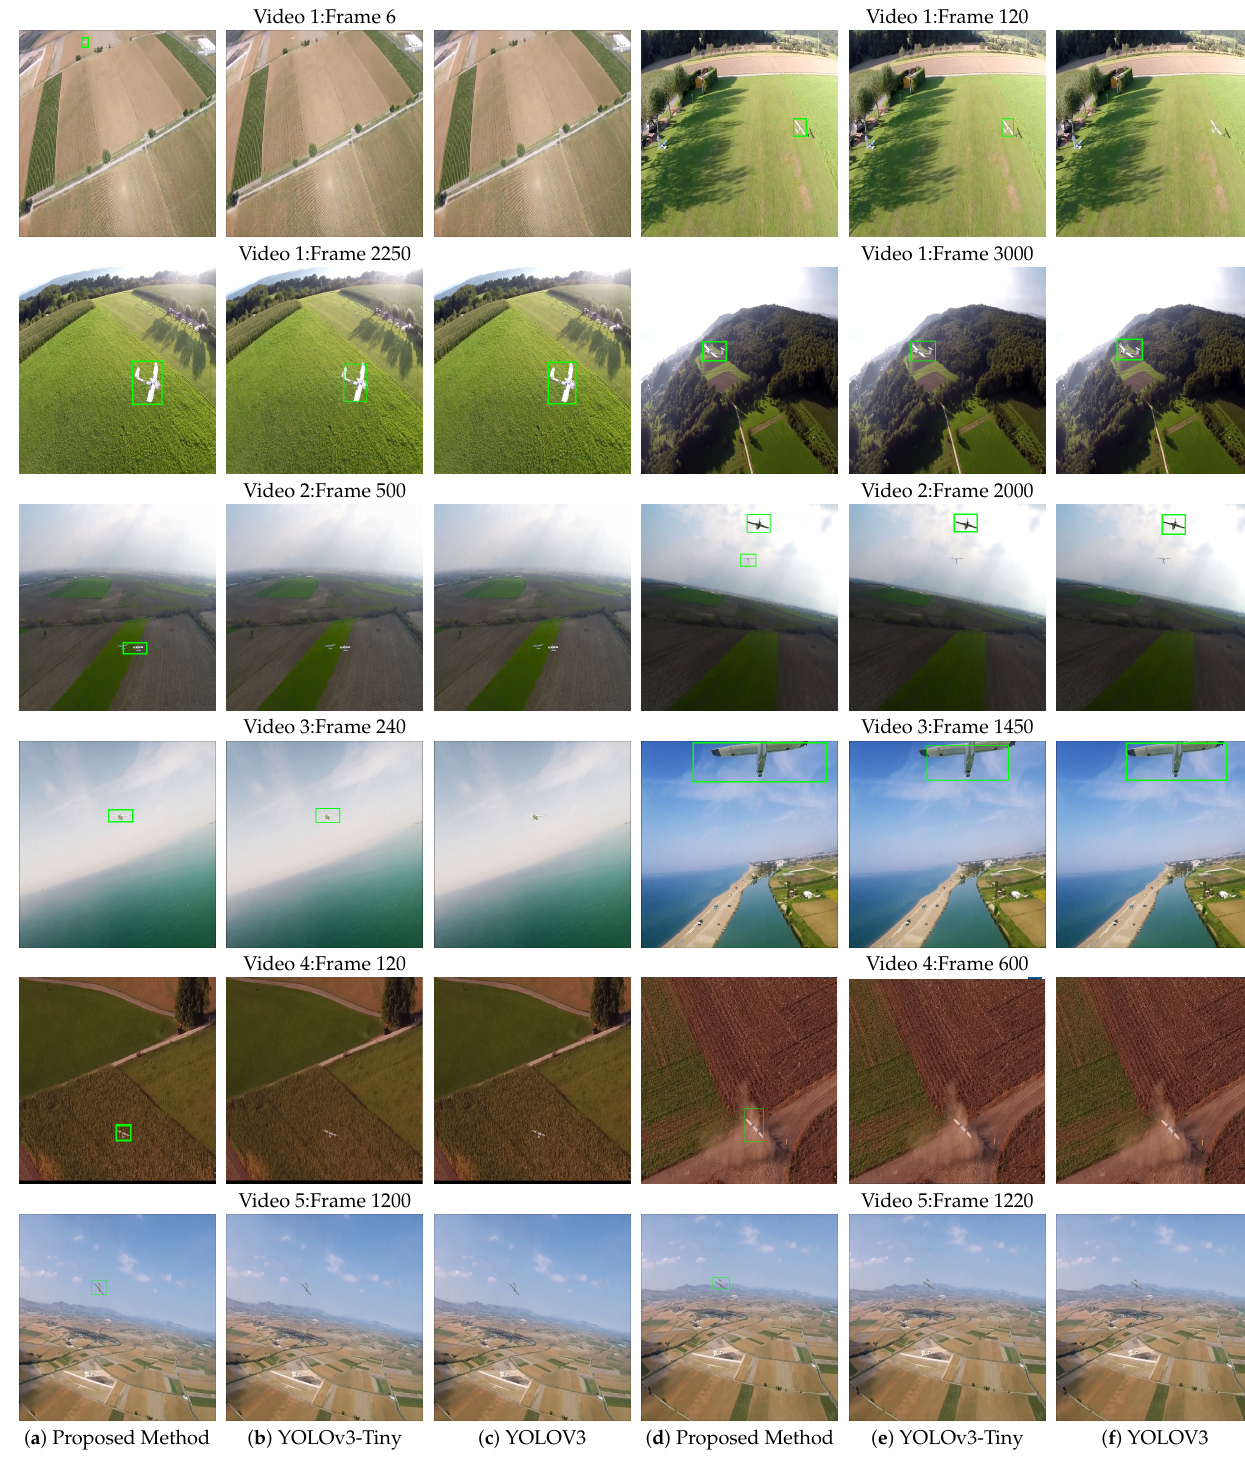
Figure 5. Illustration of UAV detection results in different video frames using proposed FastUAV-NET method, YOLOv3-tiny and